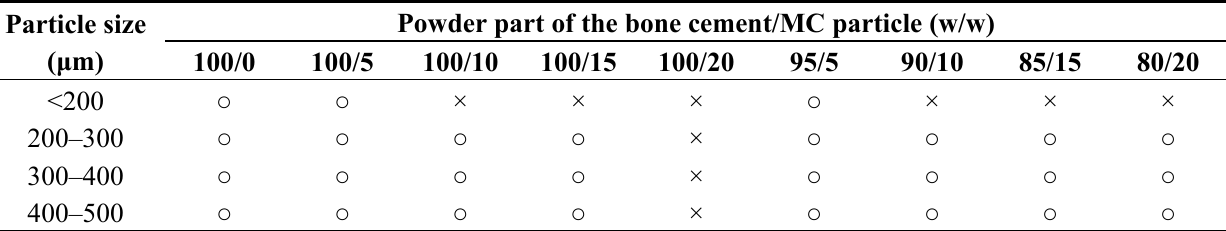
Table 2. The injectability of the MC modified Mendec ® Spine bone